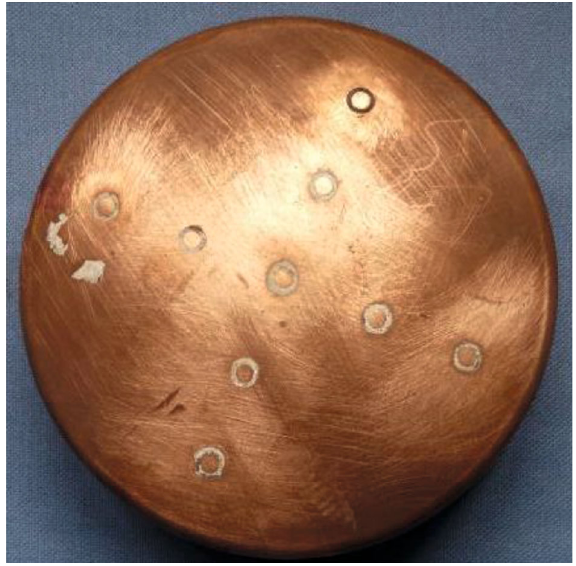
Figure 4: Blunt test model with sensors. Table 1: Test parameters of the blunt model. Enthalpy Run